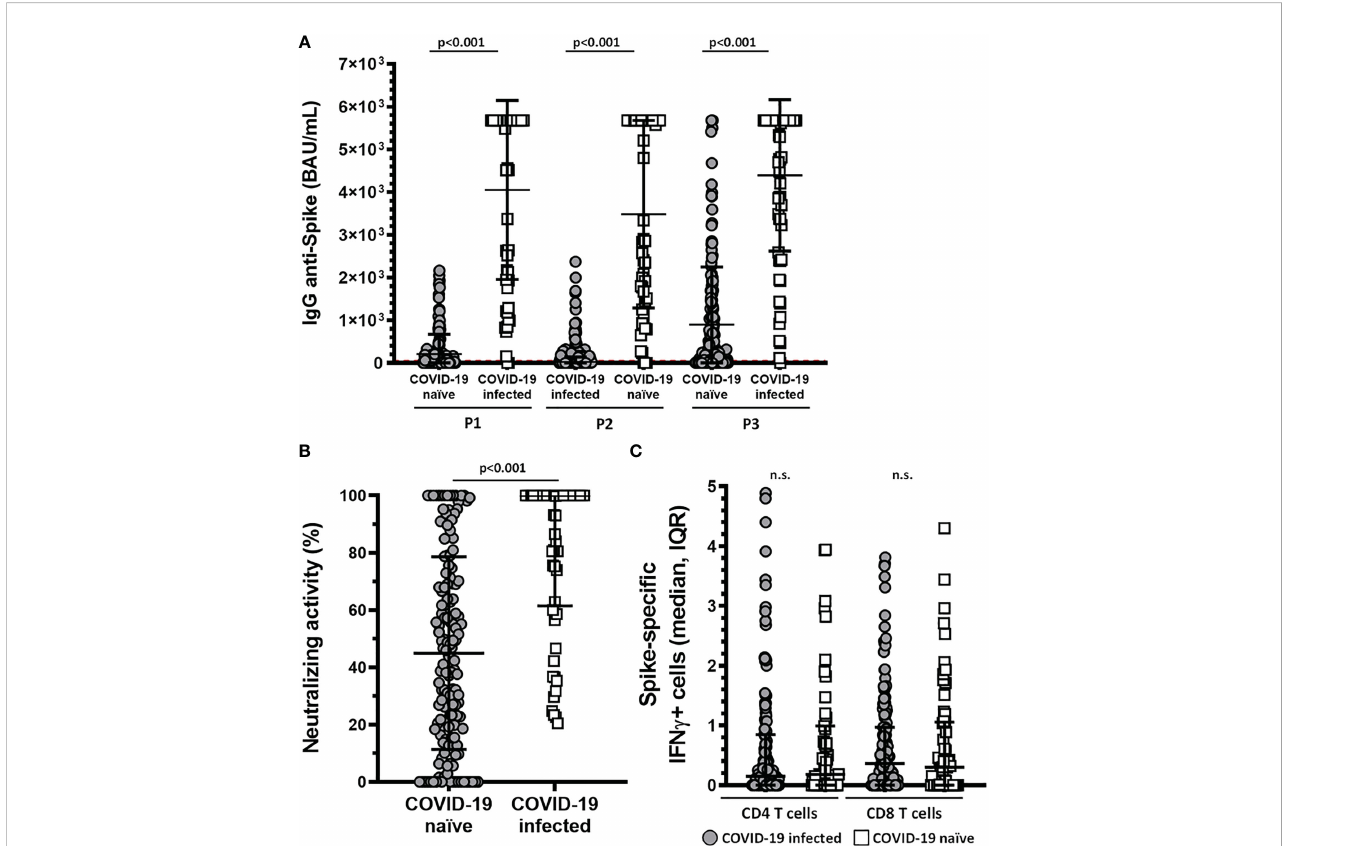
FIGURE 6 Patients affected by COVID-19 have higher levels of anti-Spike IgG antibodies and higher neutralizing activity. (A) Levels of anti-Spike IgG antibody (BAU/ mL) in COVID-19 affected and unaffected patients for each of the post-vaccination samples (p<0.001). (B) Neutralizing activity of sera after the third dose in COVID-19 affected and unaffected patients. Neutralizing activity was 78.9 in SARS-CoV-2 infected vs 43.4% (p<0.001) in SARS-CoV-2 naïve KTR. Both graphs show median and IQR, an p-value for each Mann-Whitney U test. (C) Graph show IFN g + cells in COVID-19 naïve and COVID-19 infected individuals in CD8 and CD4 T cells. Non-signi fi cant differences were found between both groups. n.s., non signi fi